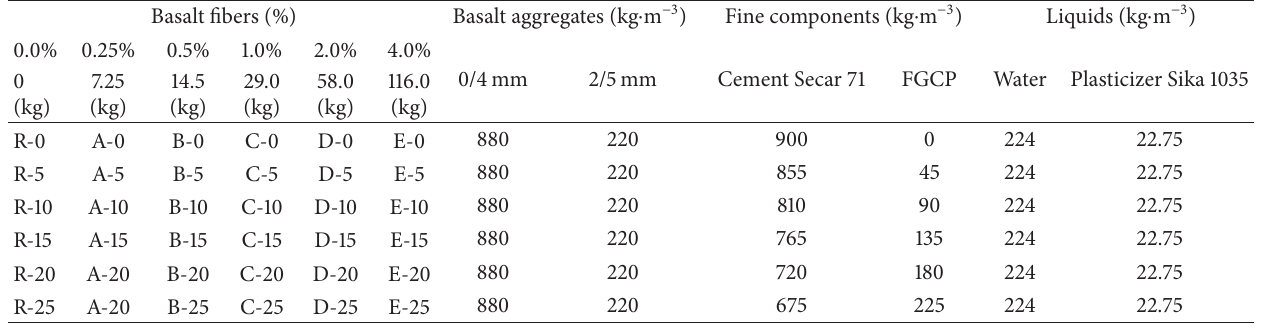
Table 1: Composition of studied composites.